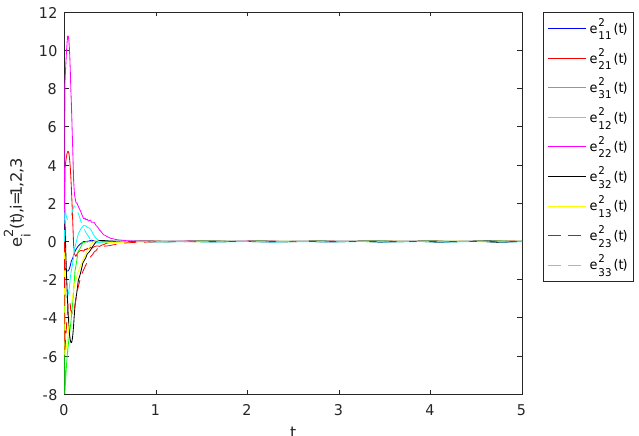
Figure 15. Synchronization error in the second layer under Controller (17).